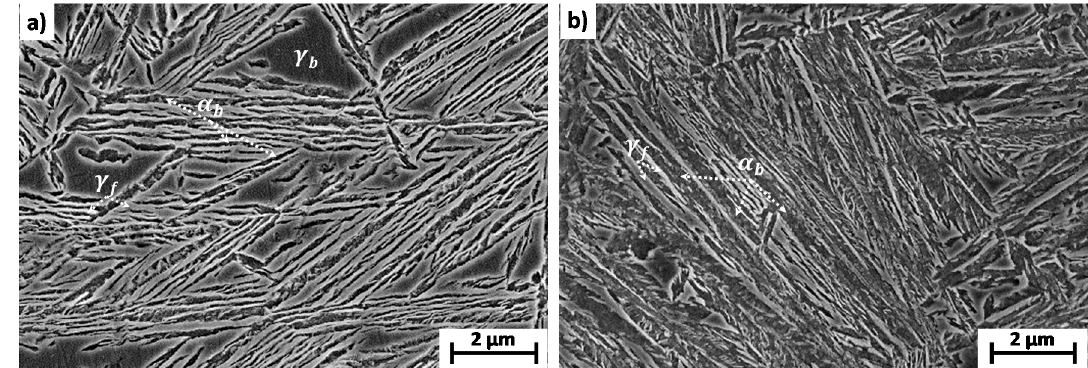
Figure 5. SEM micrographs of bainitic microstructures obtained after isothermal transformation at 300 °C (F test) in ( a ) 1C2Si steel and ( b ) 04C3Si steel, where α b stands for bainitic ferrite and γ stands for retained austenite with film (f) and block (b) morphology. Table 2. Volume fraction ( 𝑓𝑖 ) and carbon content ( 𝐶𝑖 ) of identified phase in the microstructures of 1C2Si at room temper- ature; 𝛼 (cid:3029) is bainite, 𝛼 (cid:4593) is martensite, 𝛾 is austenite and 𝛼 = 𝛼 (cid:3029) + 𝛼 (cid:4593) . P and F stand for partial and full transformation, while RT refers to room temperature and Iso refers to isothermal temperature. The martensitic transformation start tem- perature Ms, plate thickness ( t 𝛼 (cid:3029) ) and hardness HV10 are also included. An asterisk (*) indicates that no martensite was detected on cooling to room T. Dil. stands for dilatometry and DoT stands for degree of transformation. Dil. T Iso